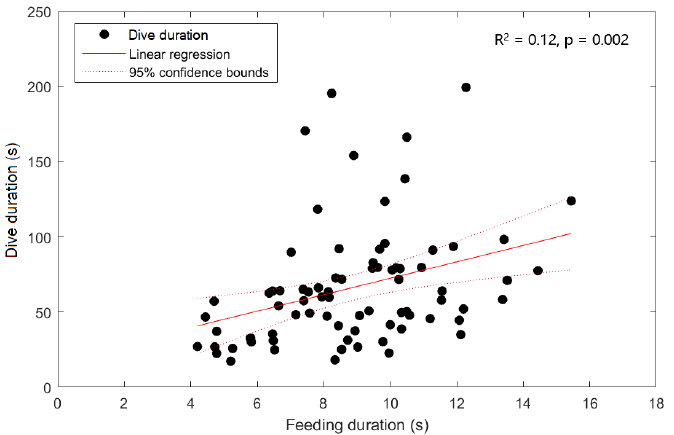
Figure 4. Linear regression model results for the correlation between the feeding duration and dive duration.